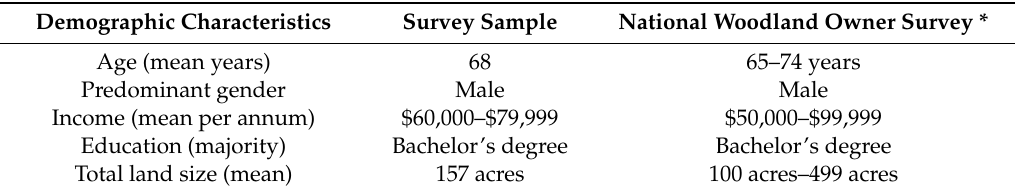
Table 1. Comparison of Mississippi’s Non-industrial Private Forest (NIPFs) sample estimates obtained